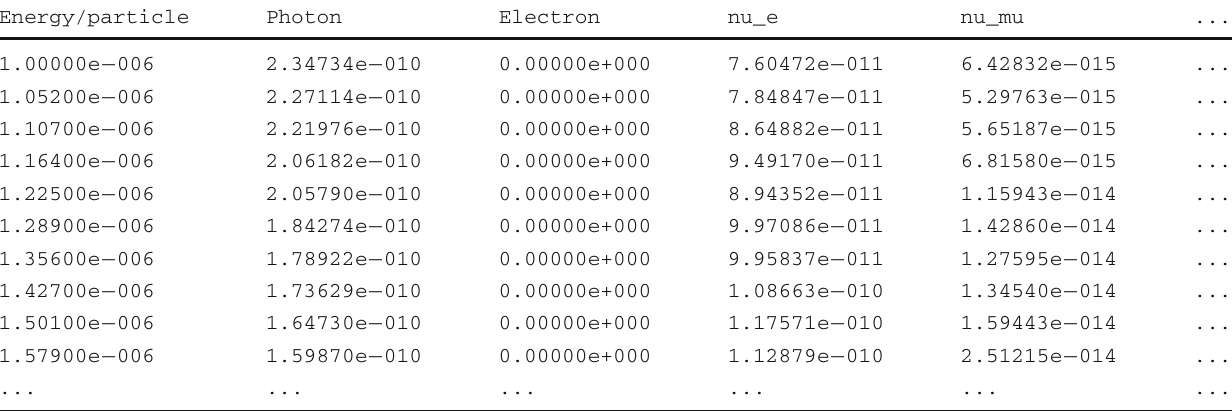
Table 10 Hawking secondary spectra for each particle type